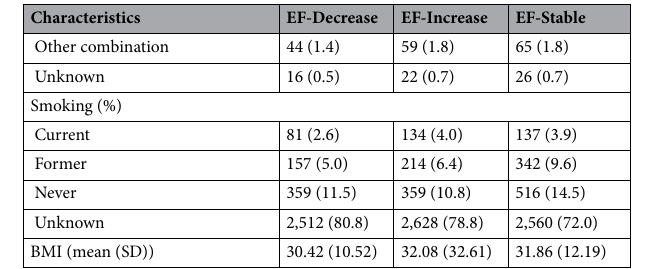
Table 2. Patient demographic characteristics at the three sites according to an increased, decreased, or stable EF.